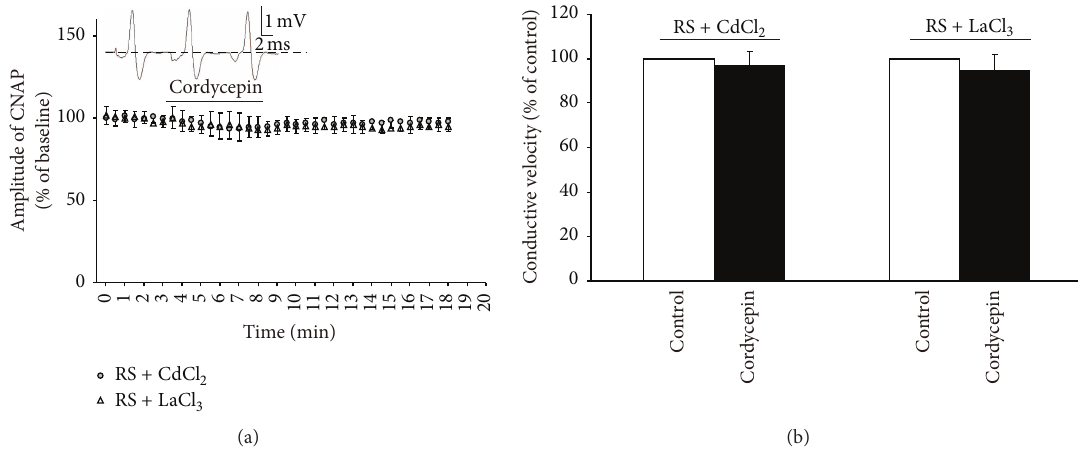
Figure 4: Effects of 50 mg/L cordycepin on amplitude and conductive velocity of compound nerve action potential (CNAP) in RS supplemented with 0.4 mM CdCl 2 or 0.15mM LaCl 3 . (a) Sample traces (top) show the CNAP recorded before, during, and after cordycepin was applied in RS + CdCl 2 medium. Below are the time courses of the effects of cordycepin on the amplitude of CNAP conduction. Horizontal bar indicates the bath application of cordycepin. (b) Summary of changes in conductive velocity of CNAP induced by cordycepin. The velocity of the stable state before the nerve was exposed to cordycepin is defined as the control value and scaled to 100%.